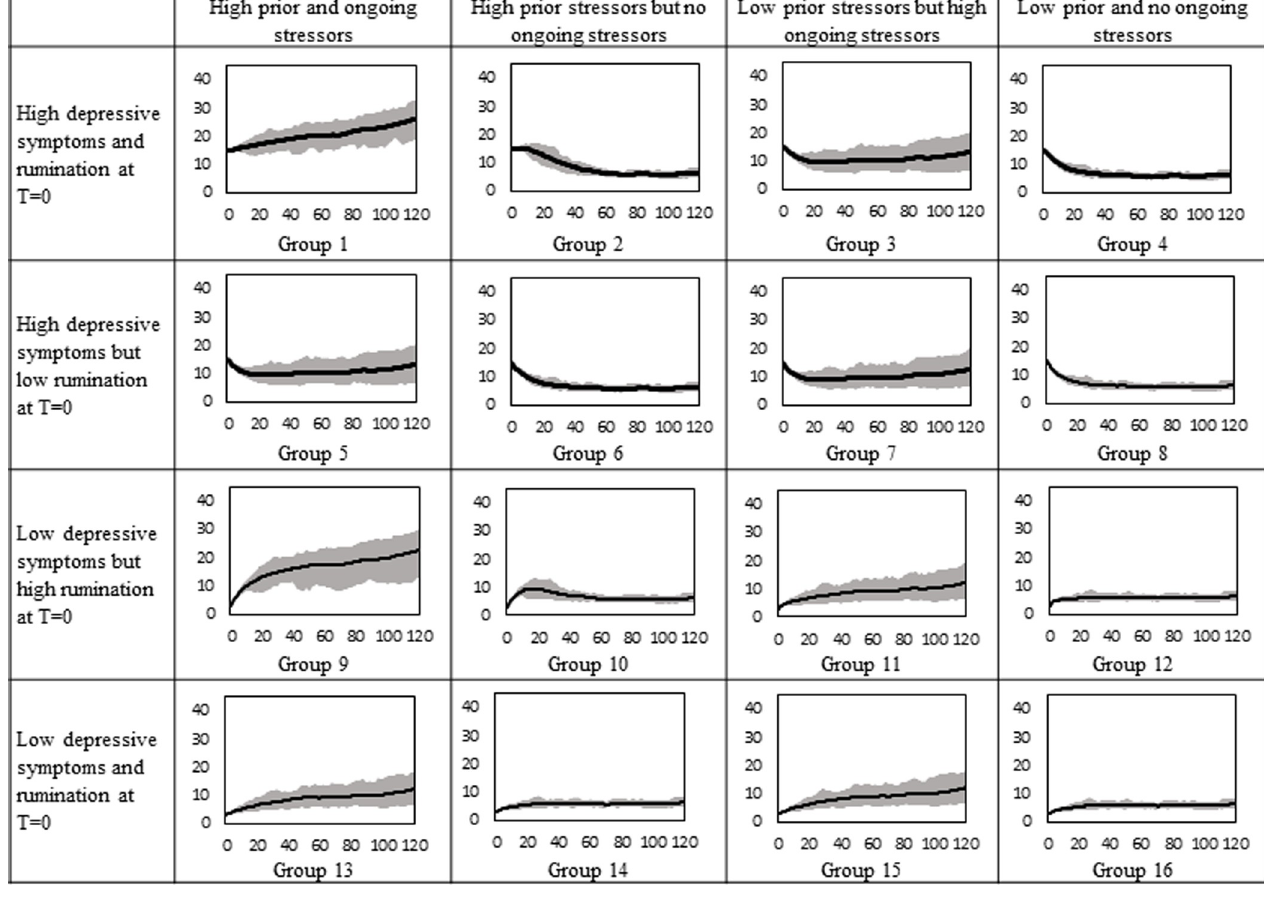
Fig 3. Simulated depressive symptoms over 120 months for 16 male